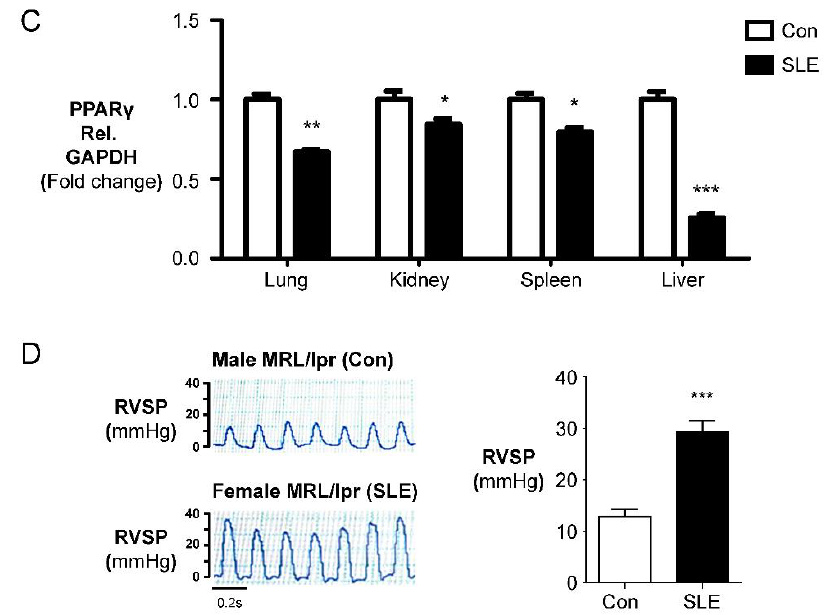
Figure 1. Increased cathepsin S and decreased PPAR γ expression are the markers of PAH related to SLE. ( A ) Western blot analysis of cathepsin S and PPAR γ in the organs of female MRL/lpr mice (SLE) compared to male MRL/lpr (Con) mice. ( B , C ) Relative expression values obtained by densitometry of the cathepsin S and PPAR γ protein normalized to GAPDH ( n = 3 per group). GAPDH = glyceraldehyde-3-phosphate dehydrogenase. The data are presented as the mean ± SEM of four samples in each group. * p < 0.05, ** p < 0.01, *** p < 0.001 compared with the control (Con) group. ( D ). Representative RVSP tracings of male and female MRL/lpr mice at the age of 15 weeks. Pulmonary hypertension (indicated by an elevated RVSP) showed increased RVSPs in the female MRL/lpr mice (SLE) groups. Increased cathepsin S and loss PPAR γ protein expression enhanced the RVSP in female MRL/lpr mice (SLE). The data are presented as the mean ± SEM of four samples in each group. *** p < 0.001 compared with the Con group.